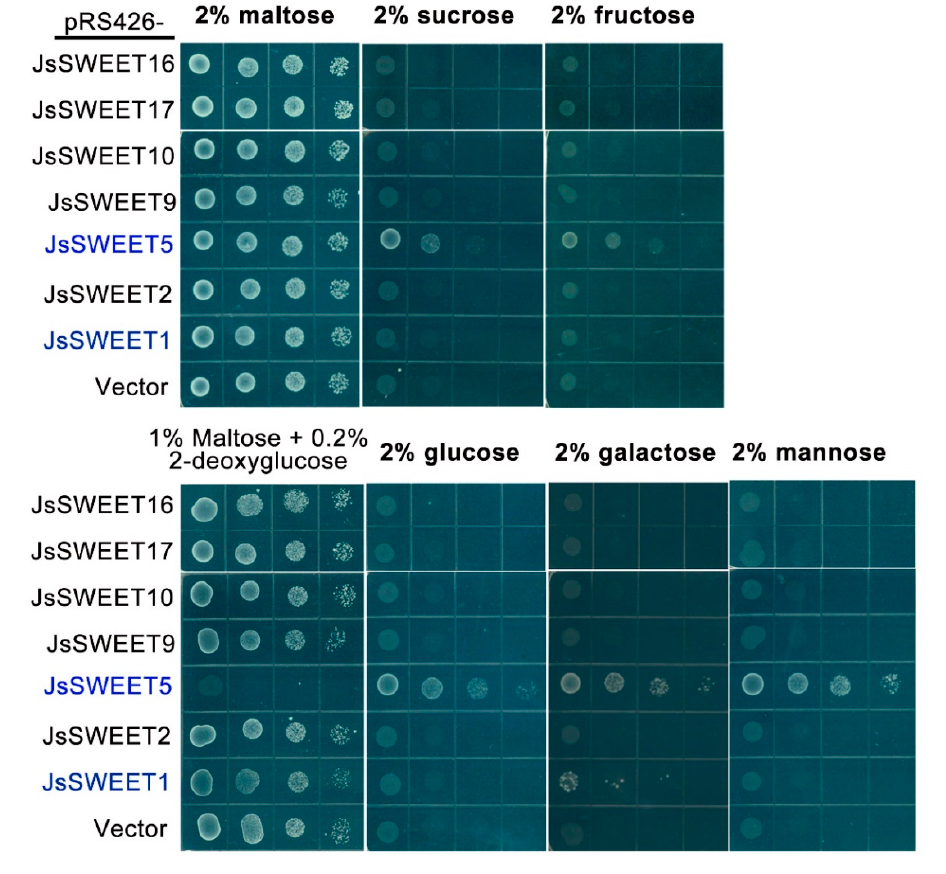
Figure 6. Growth complementation assay in yeast deficient strain EBY4000 by the expression of the JsSWEETs . Ten microliter each of a serial 10-fold diluted cell suspensions were dropped in selection media containing 0.67% Difco yeast nitrogen base with ammonium sulfate supplemented with leucine, tryptophan, histidine, and the indicated carbon sources). Maltose medium serves as a growth control for plasmid maintaining. Note that only yeast cells expressing JsSWEET1 and JsSWEET5 (highlighted in blue) showed growth complementation.